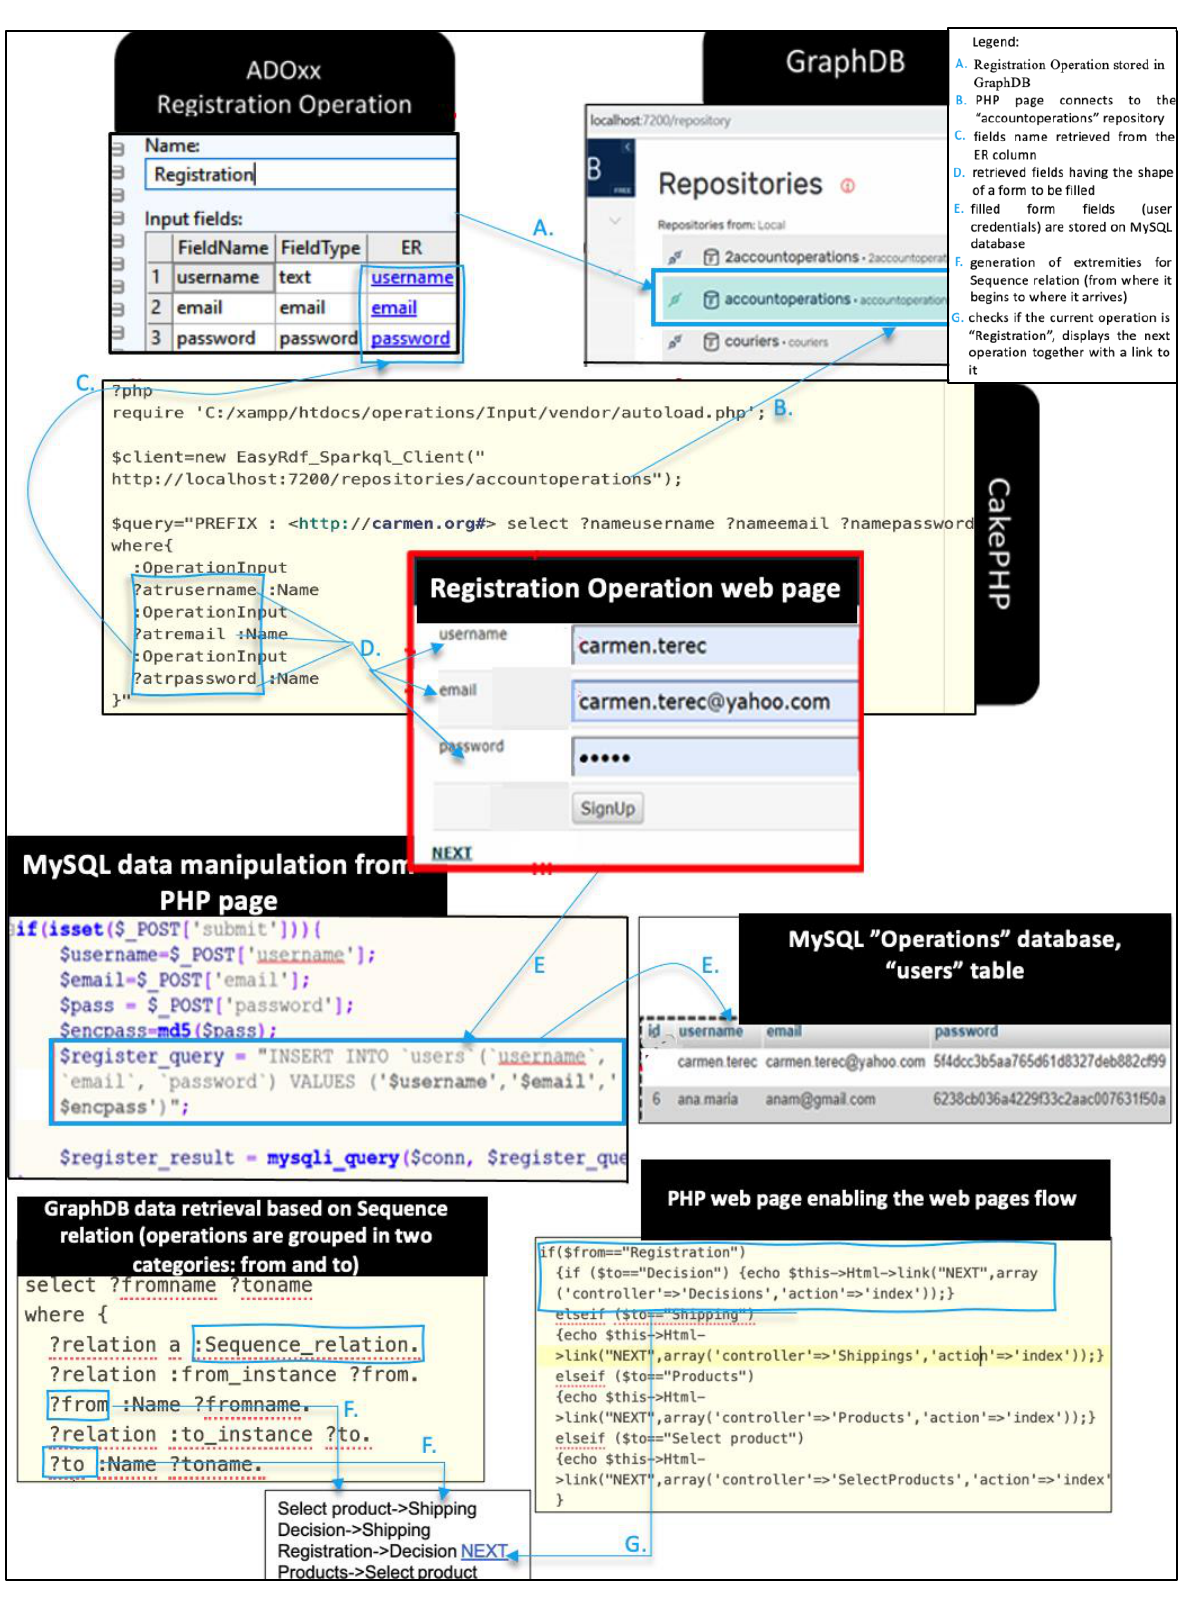
Figure 10. Operations within Registration